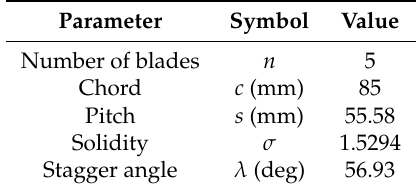
Table 1. Geometric features of the experimental setup for the ARL-SL19